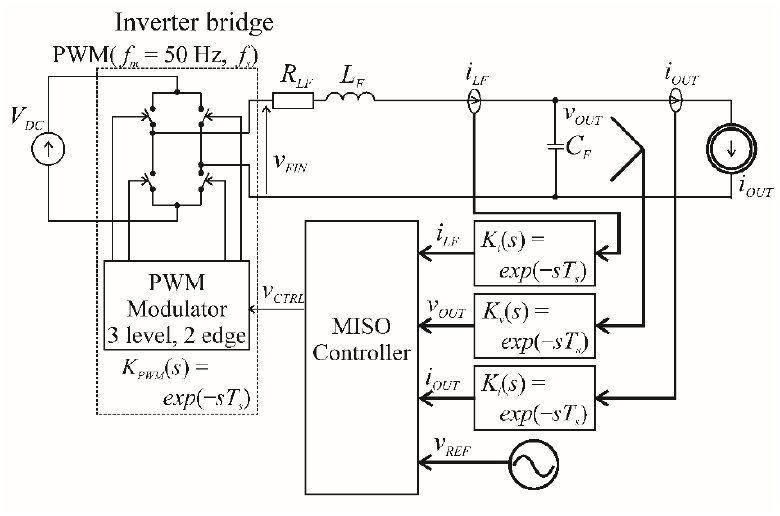
Figure 9. MISO control of a VSI.